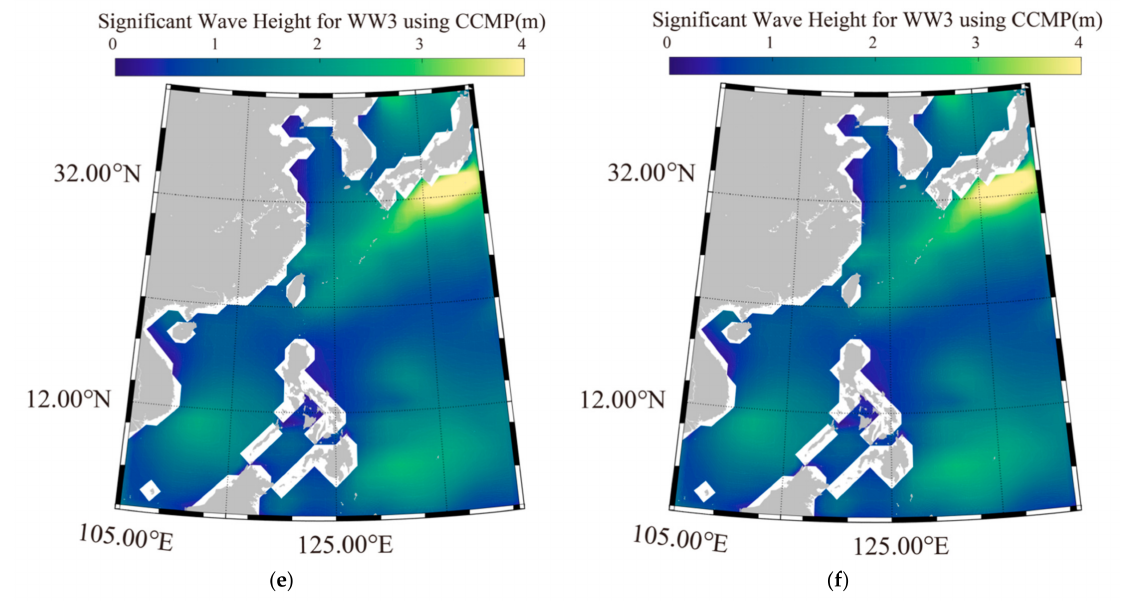
Figure 7. The six SWH maps simulated using SWAN and WW3 models on July 1 2015 at 12:00 UTC using three forcing winds. ( a ) The simulation from the SWAN model using ECMWF wind data. ( b ) The simulation from the SWAN model using CCMP wind data. ( c ) The simulation from the SWAN model using NCEP wind data. ( d ) The simulation from the WW3 model using ECMWF wind data. ( e ) The simulation from the WW3 model using CCMP wind data. ( f ) The simulation from the WW3 model using NCEP wind